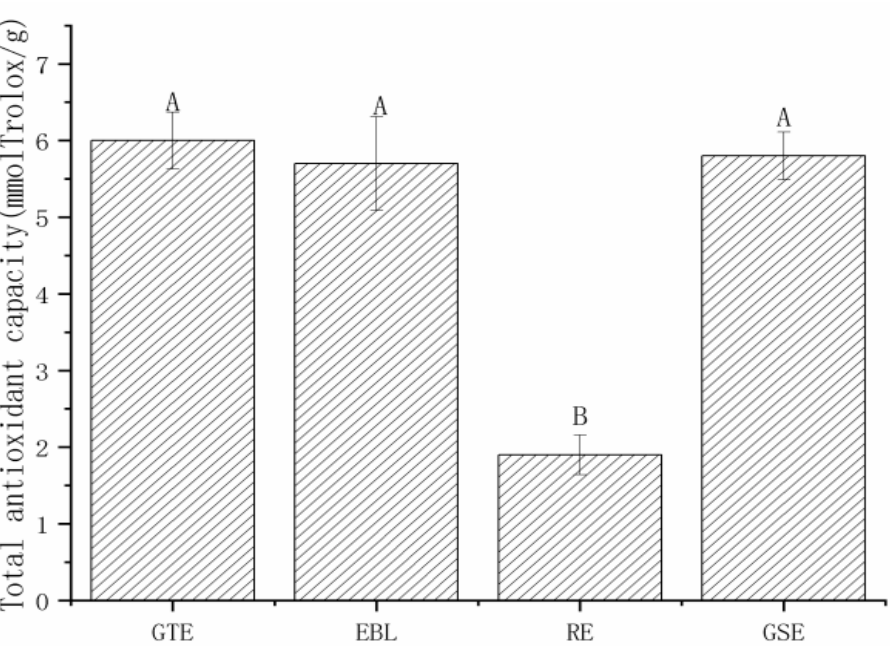
Figure 2. The total antioxidant capacities of four extracts (by TEAC assay). Note: GTE: pickling solution with green tea extract; EBL: pickling solution with extract of bamboo leaves; GSE: pickling solution with grape seed extract; RE: pickling solution with rosemary extract. The same letters (A and B) indicate that there is no significant difference ( p < 0.05).